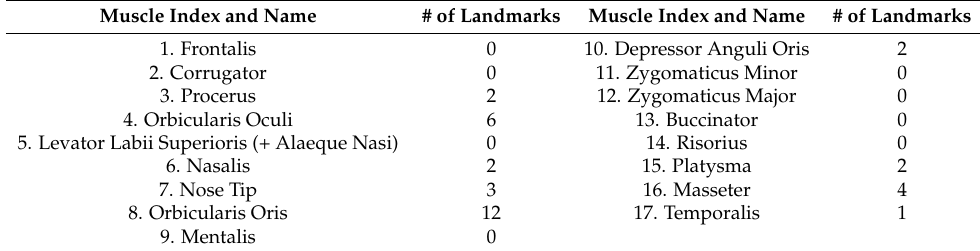
Table 2. The 68 facial landmarks in the defined facial muscle